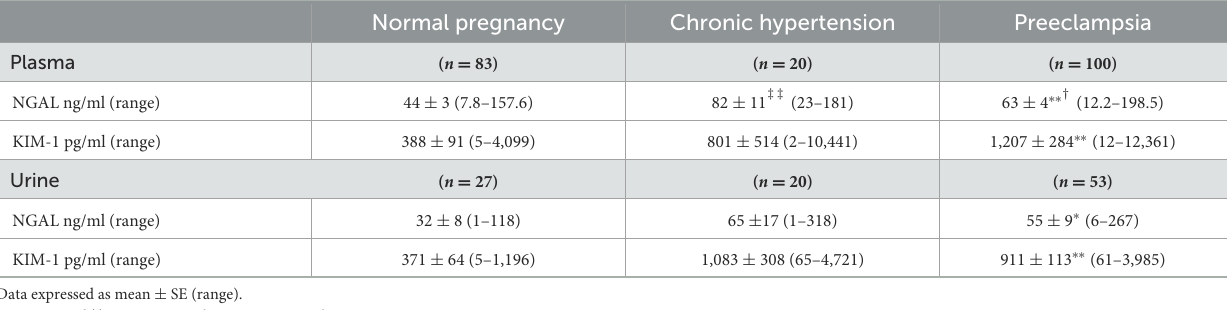
TABLE 3 Maternal and urine concentrations of NGAL and KIM-1 in normal pregnant women and in pregnant women complicated with chronic hypertension or preeclampsia. Normal pregnancy Chronic hypertension Preeclampsia Plasma